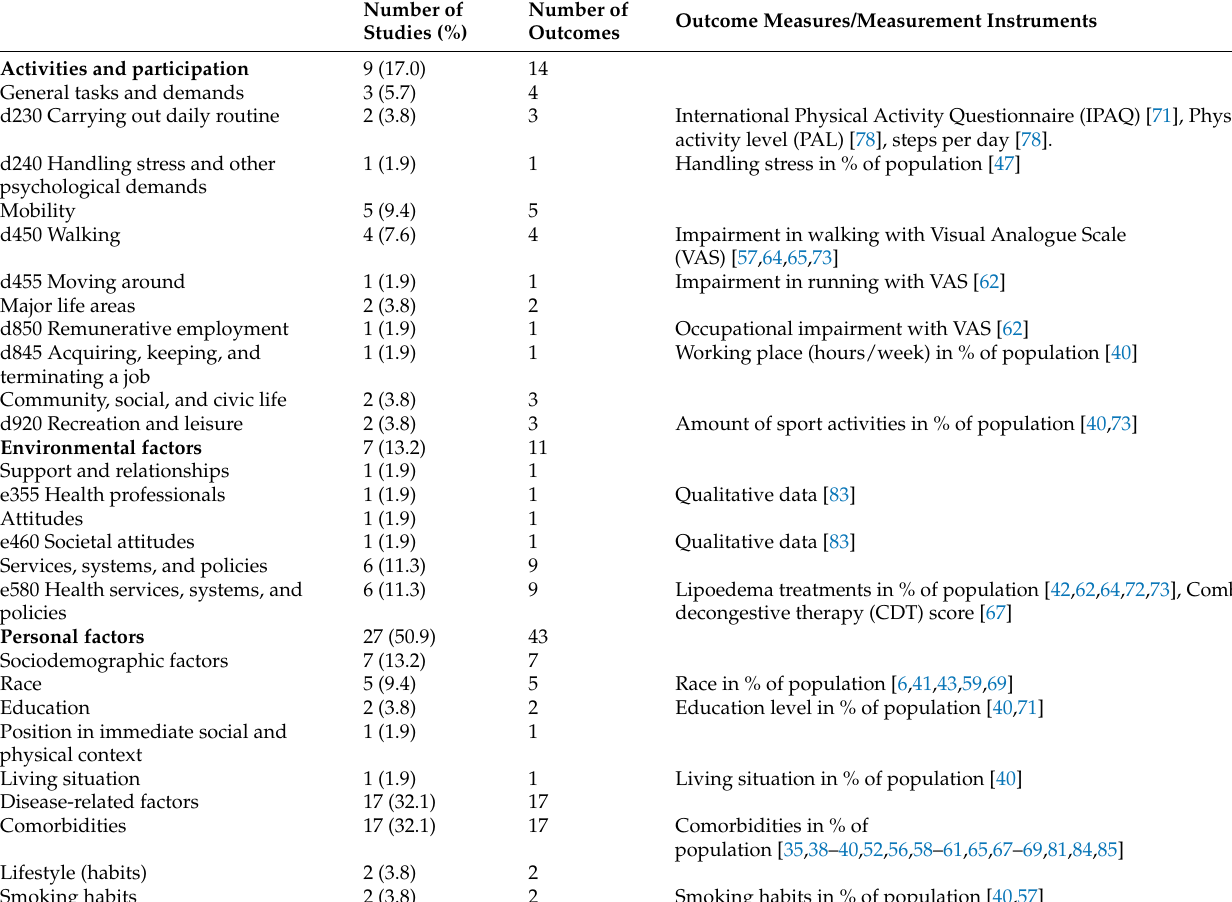
Table 2. Frequencies of codes and outcomes used within the themes “activities and participation”, “environmental factors”, and “personal